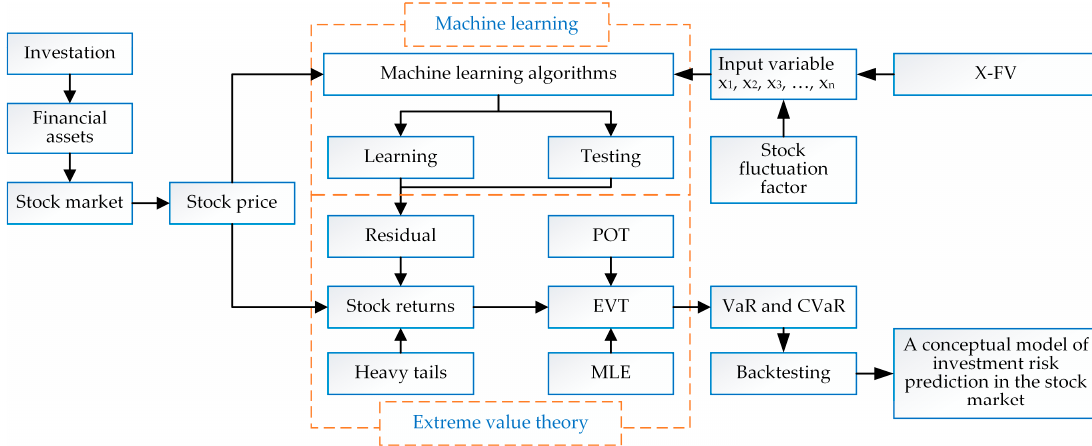
Figure 10. Conceptual model